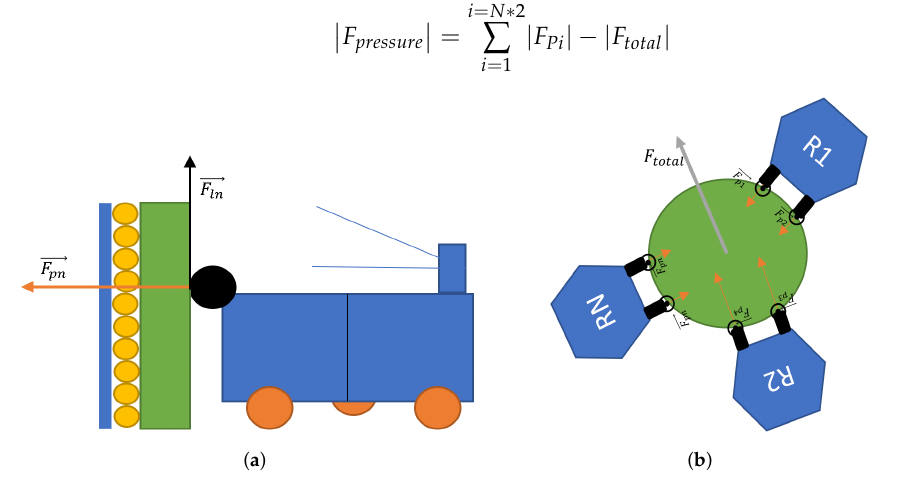
Figure 4. Concept: ( a ) single robot scenario; and ( b ) multi-robot scenario.